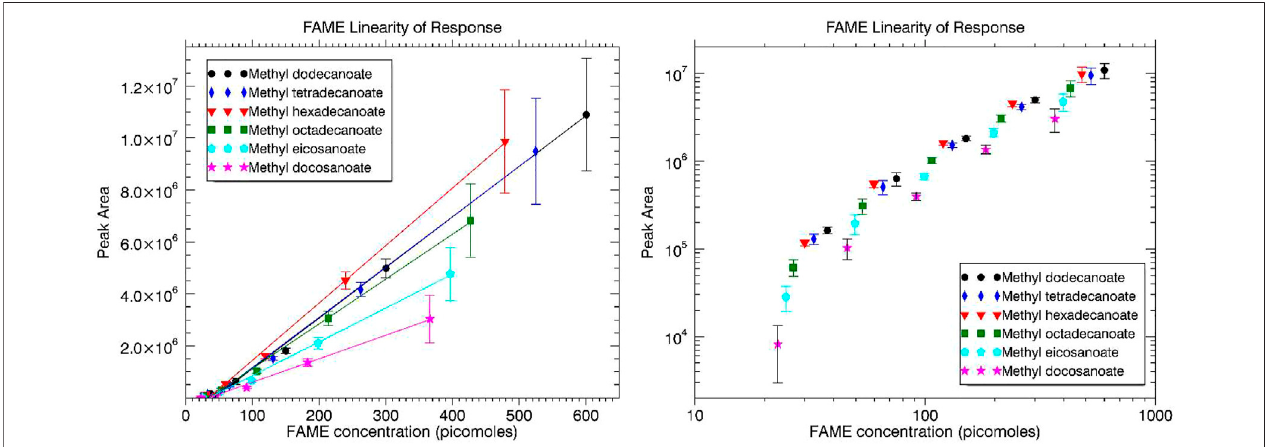
FIGURE 3 | FAMEs linearity of response in terms of peak area versus FAME concentration injected (picomoles) plotted with linear axes at left and logarithmic axes at right.